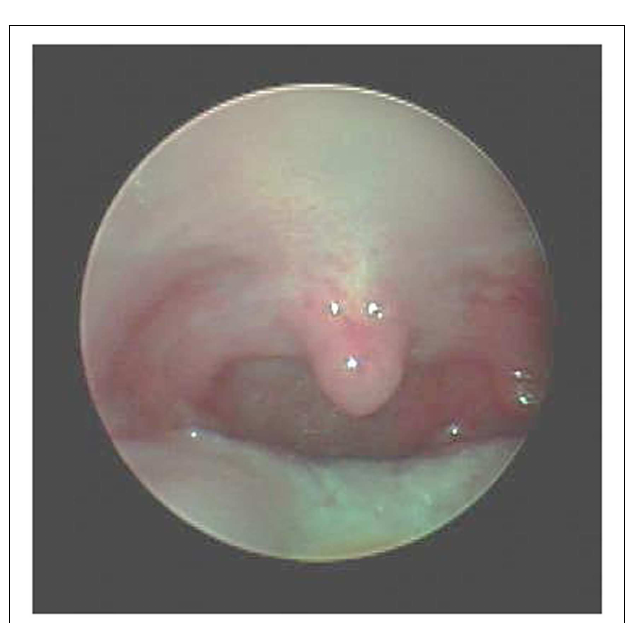
FIGURE 2 | Post-operative view of palate after lateral sphincter pharyngoplasty .